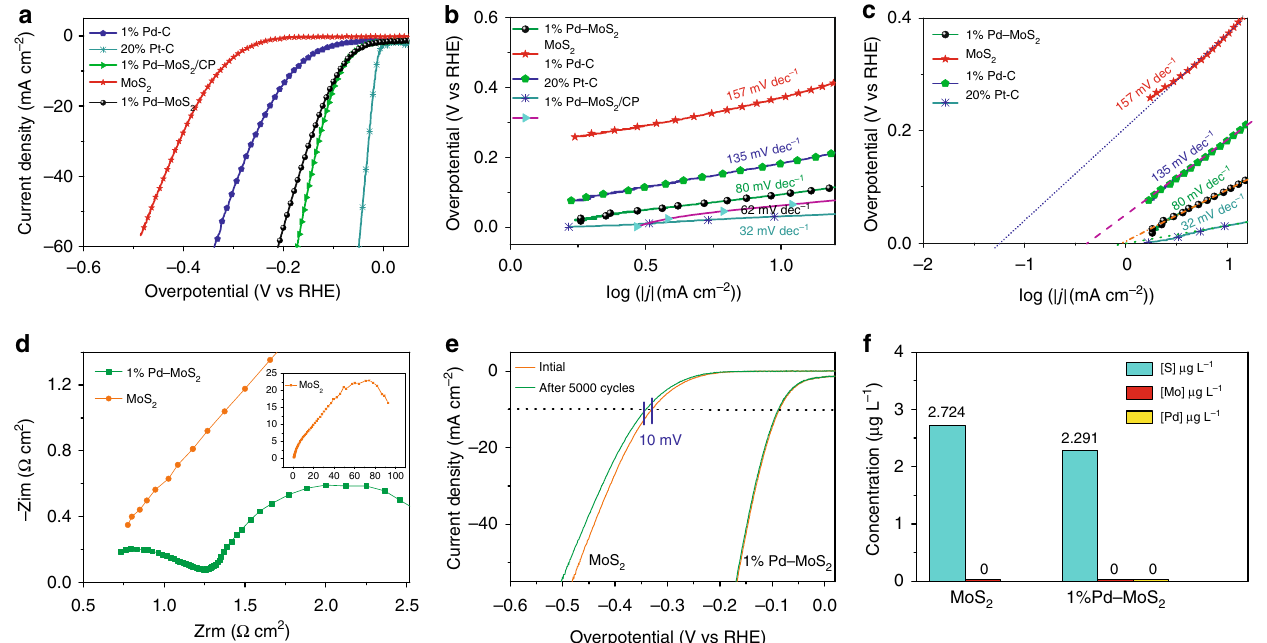
Fig. 3 Superior activity and stability of 1%Pd – MoS 2 . a LSV polarization curves of MoS 2 , 1%Pd – MoS 2 , 1%Pd – MoS 2 /CP, 1%Pd – C, and 20%Pt – C (with iR correction). b Tafel plots derived from the results given in Fig. 3a. c Exchange current density for the MoS 2 , 1%Pd – MoS 2 , 1%Pd – C and 20%Pt – C samples, derived from the Tafel plots, as indicated by the dashed lines. d EIS comparison for the MoS 2 and 1%Pd – MoS 2 in terms of Nyquist plots; inset, the full- spectrum for the MoS 2 . e Stability measurements for MoS 2 and 1%Pd – MoS 2 using accelerated degradation tests (5000 cycles, 100 mV s − 1 ); polarization curves are shown without iR correction. f ICP-OES results of dissolved S, Mo, and Pd ions in the electrolyte after the stability tests shown in Fig.